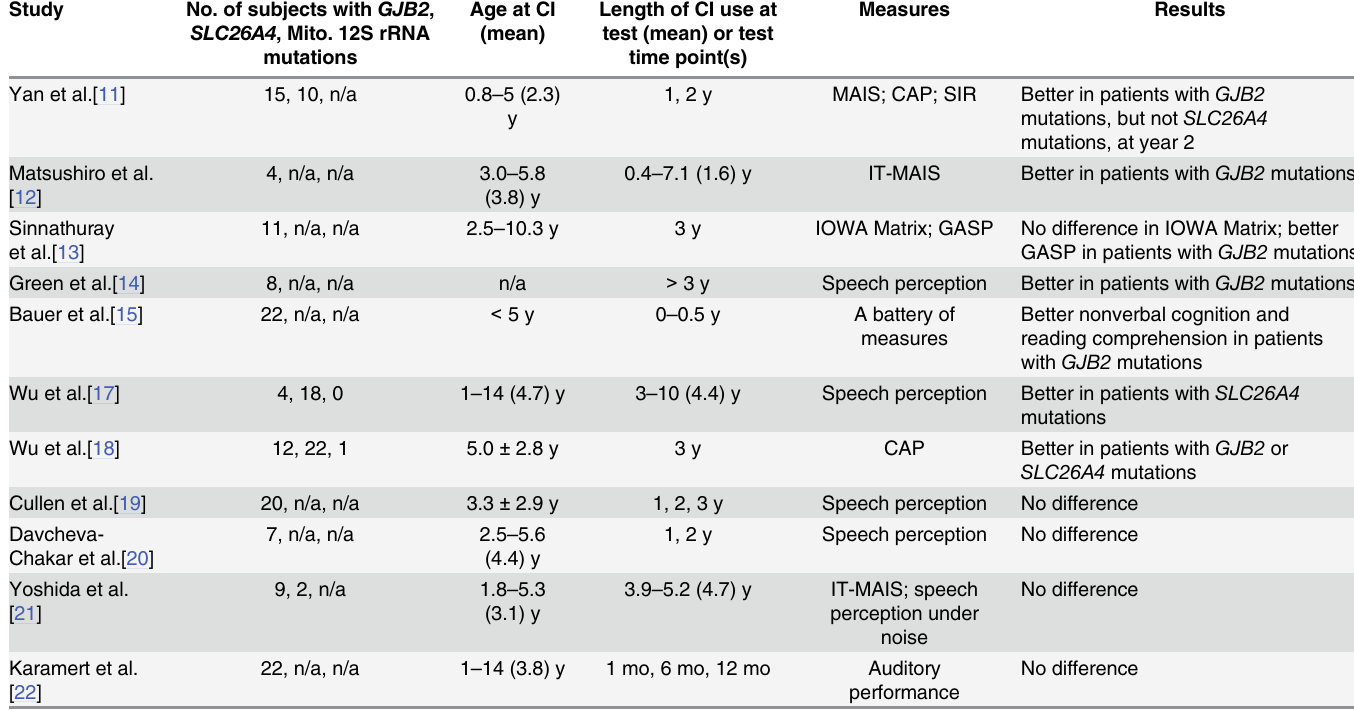
Table 1. Review of studies on language/speech outcomes in cochlear implanted patients with mutations in GJB2 , SLC26A4 or the mitochondrial 12S rRNA